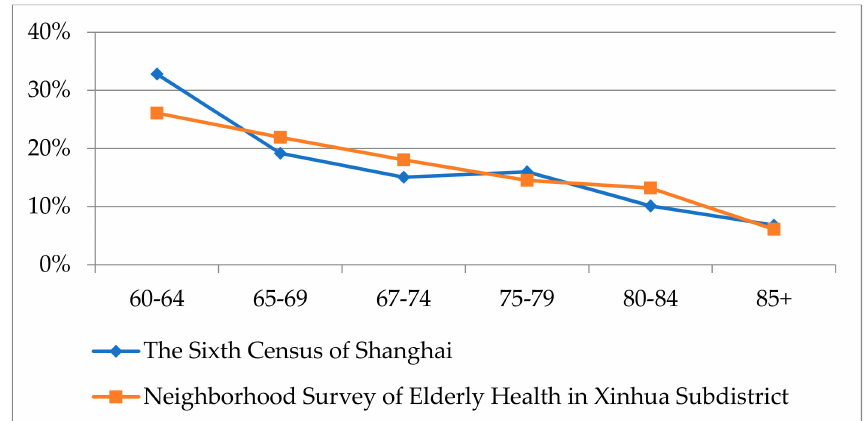
Figure 3. Comparison of age